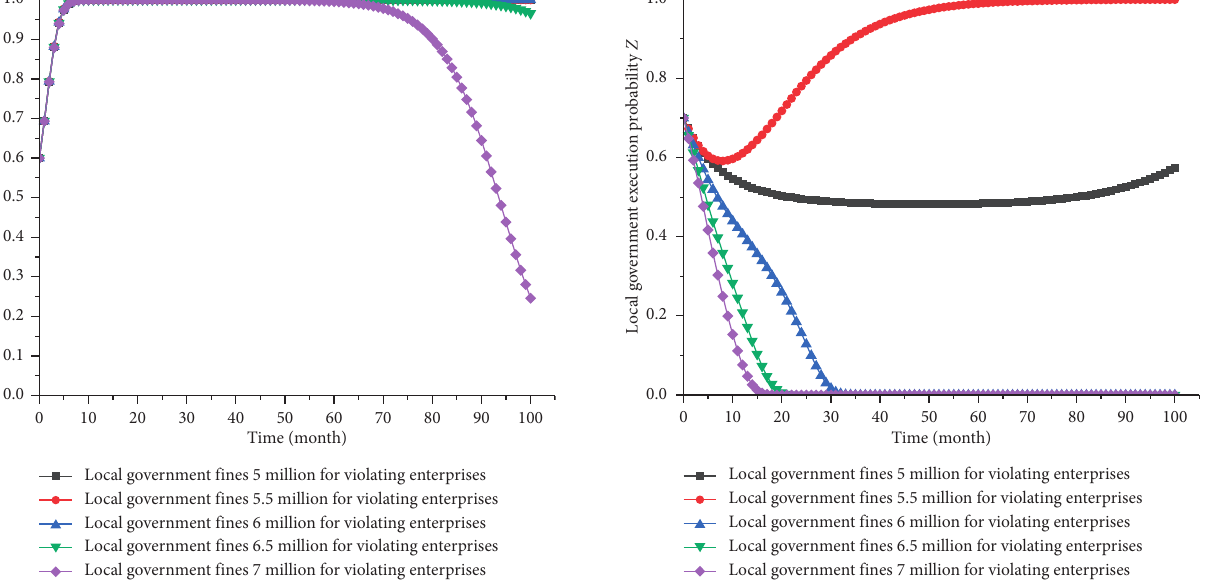
Figure 15: The impact of local fines on central government strategy choices.